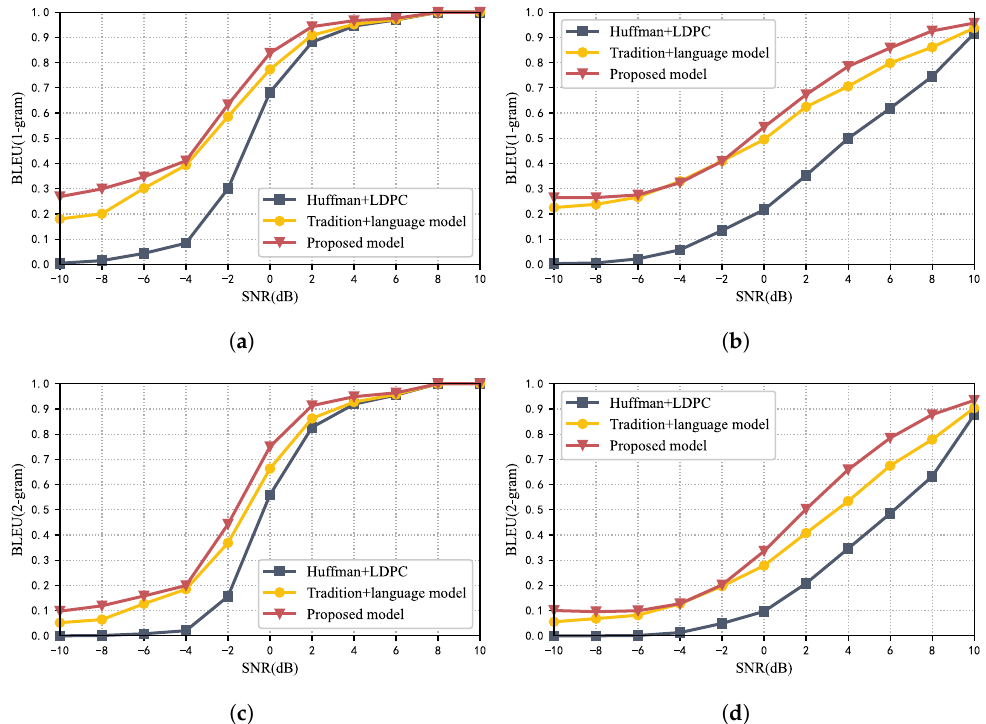
Figure 3. BLEU score versus SNR over the AWGN channel and the Rayleigh fading channel. ( a ) BLEU (1-g) score over the AWGN channel. ( b ) BLEU (1-g) score over the Rayleigh channel. ( c ) BLEU (2-g) score over the AWGN channel. ( d ) BLEU (2-g) score over the Rayleigh channel.